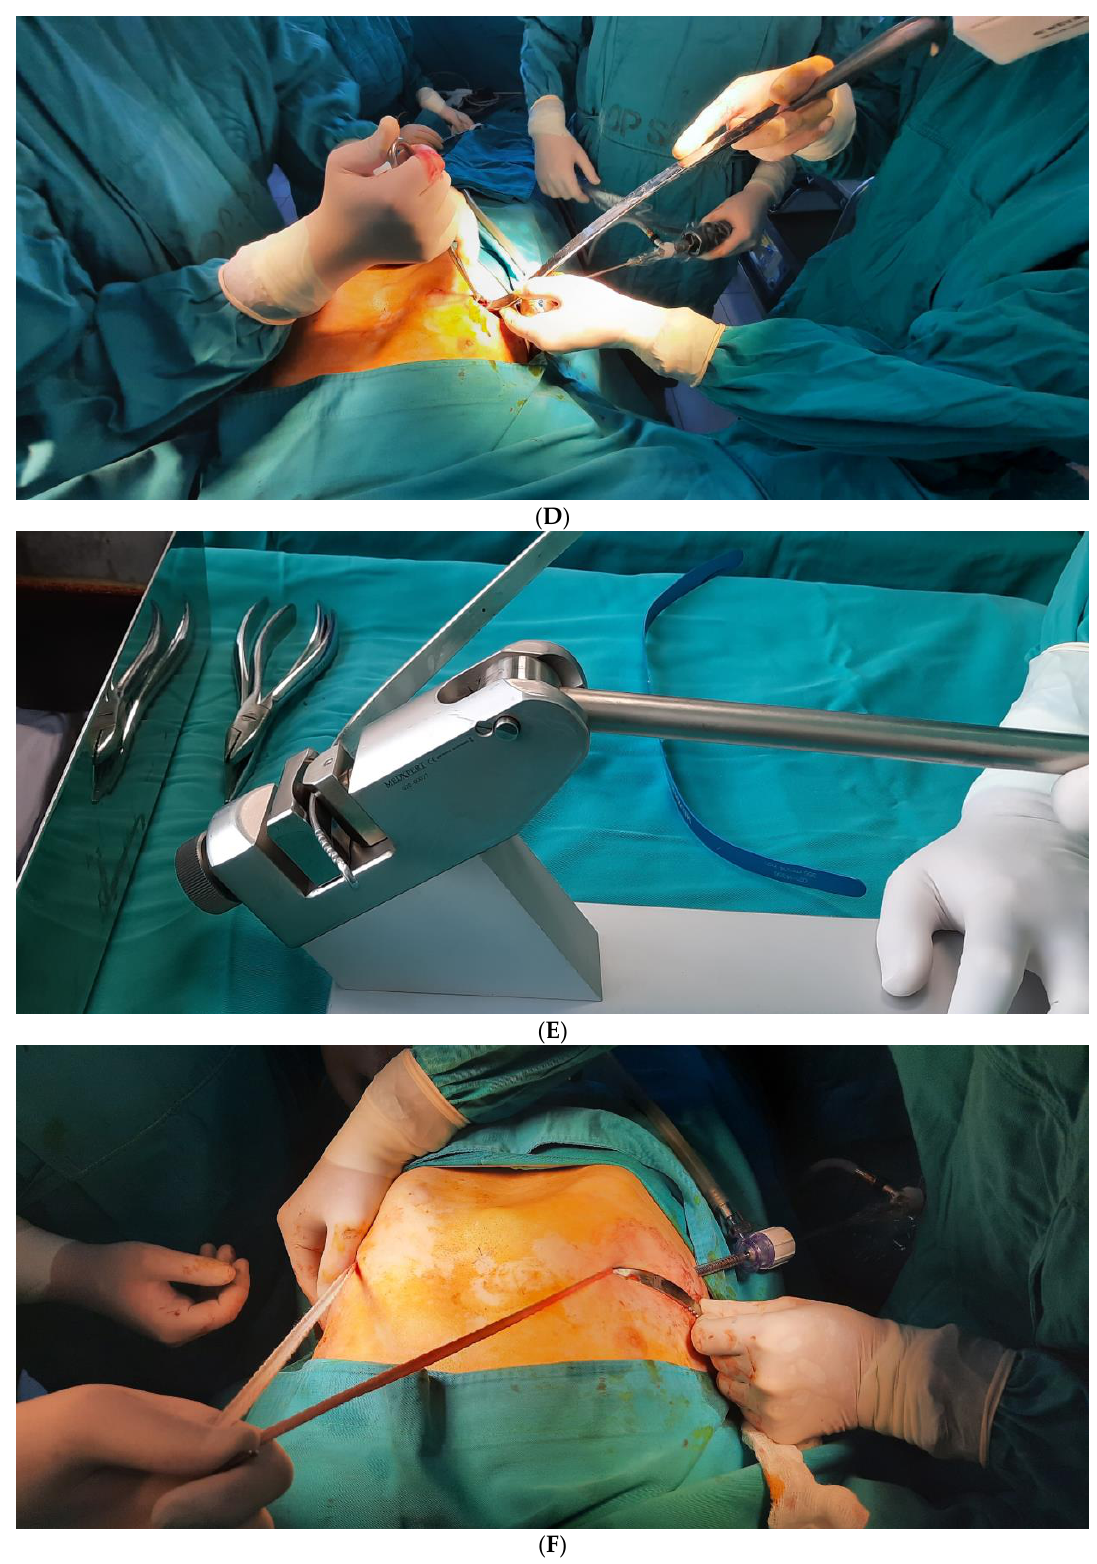
Figure 1. ( A ) Pectus excavatum deformity before the surgery. ( B ) Configurated and modified plastic model of the pectus bar. ( C ) The use of a thoracoscopic camera during the Nuss procedure. ( D ) The use of the Lorenzo introducer. ( E ) Shaping of the metal/titanium pectus bar based on the plastic model. ( F ) The bar was flipped for its final placement with its convexity to the